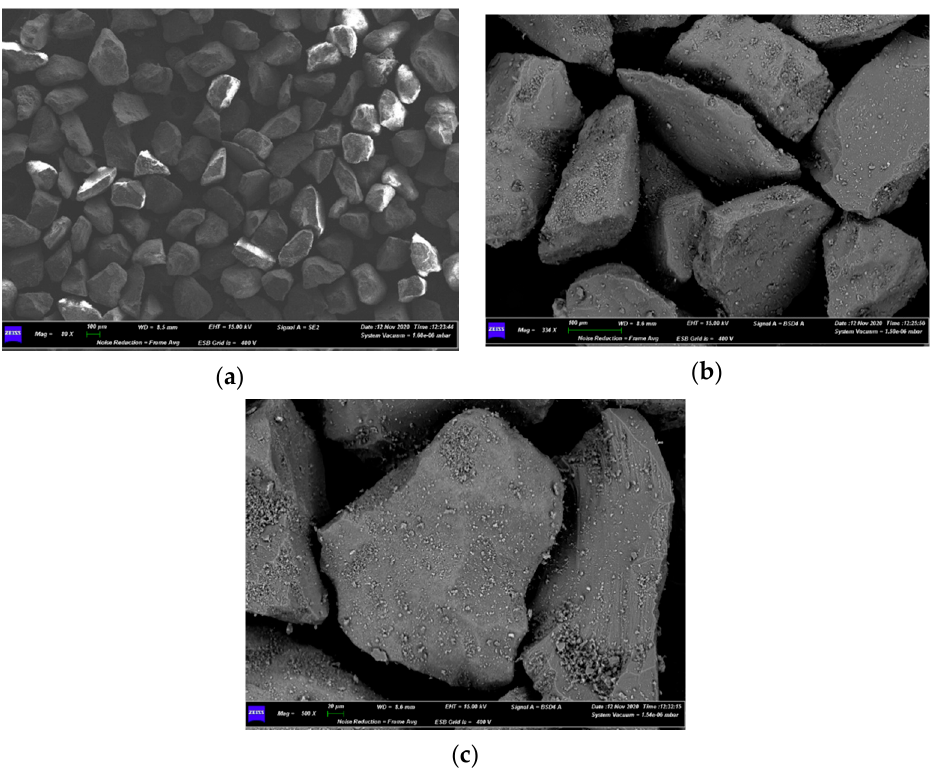
Figure 12. SEM micrographs of top of spent sand bed after the last test, magnified at: 80× ( a ); 334× ( b ); 500× ( c ).